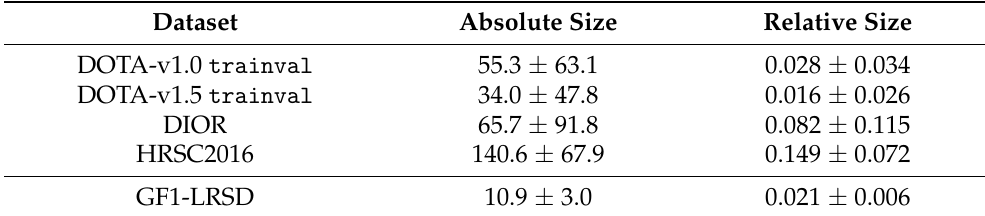
Table 1. Mean and standard deviation of instance size on different